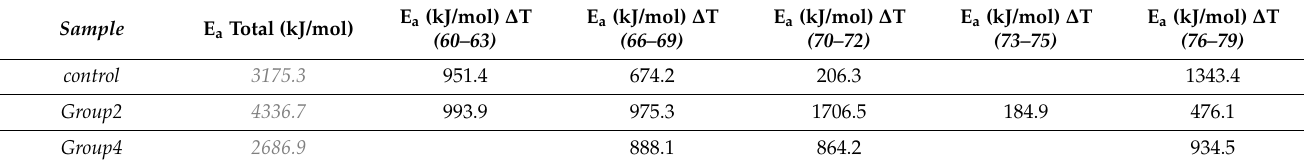
Table 4. Contribution of activation energies (gray numbers) resulted by the analysis of deconvolved data from Figure 2 in the different temperature ranges of the peaks ( ∆ T). (The empty fields indicating missing data as the fitting does not work properly with small peaks, thus cannot result applicable values, recently evaluated).